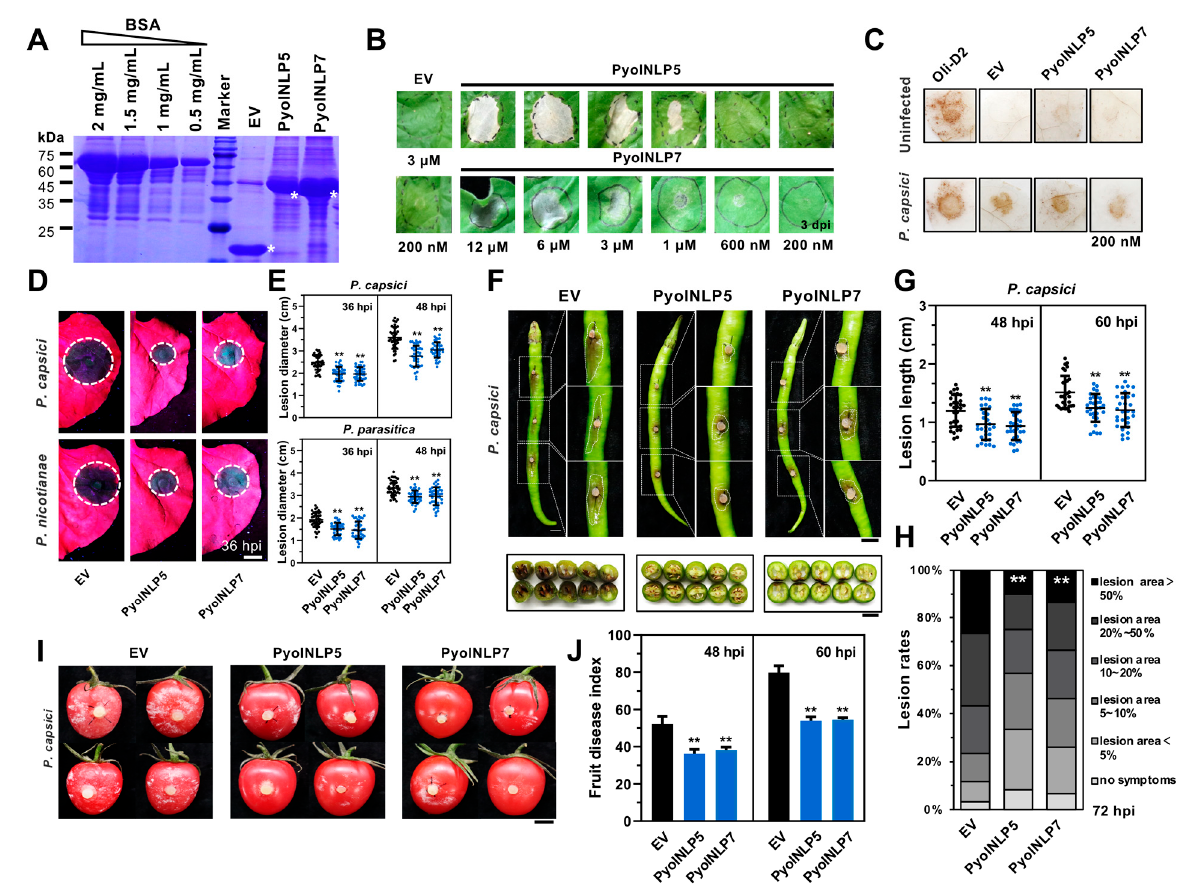
Figure 5. Recombinant PyolNLP5 and PyolNLP7 proteins suppress the infection of Phytophthora pathogens in Nicotiana benthamiana , pepper and tomato fruits. ( A ) SDS-PAGE analysis of PyolNLP5 and PyolNLP7 proteins stained with coomassie blue. Recombinant proteins were expressed in E. coli using the pET32a vector and partially purified using Ni- NTA resin. Asterisks indicate the objective bands. ( B ) Representative N. benthamiana leaves infiltrated with partially purified PyolNLP5 or PyolNLP7 proteins (200 nM to 12 μ M). Partially purified protein from an empty vector (EV)